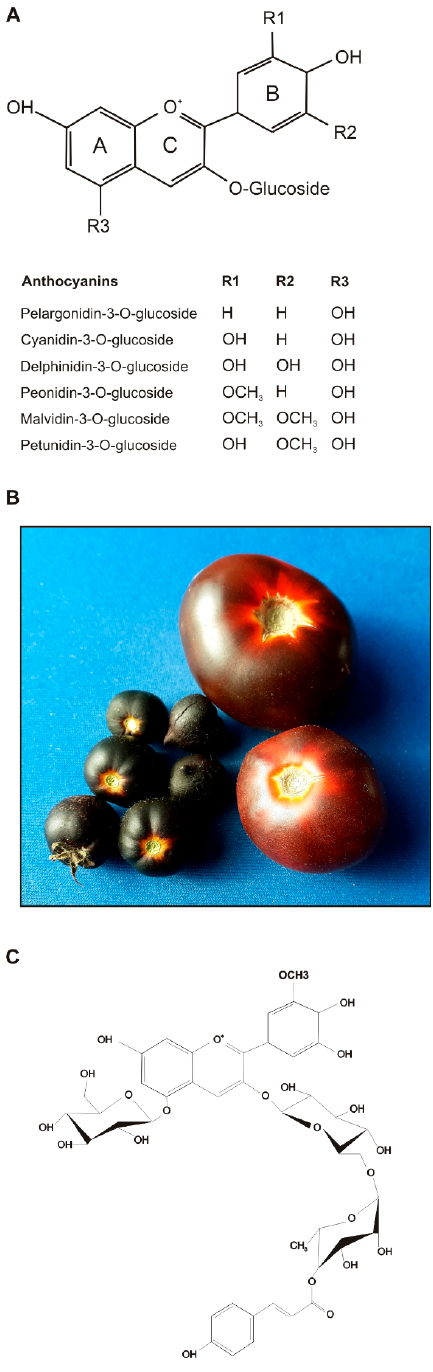
Figure 1. General anthocyanin structure and list of the most common anthocyanins found in nature (from [5]) ( A ). Examples of purple tomato fruits obtained by breeding: Aft / Aft x atv / atv x hp2 / hp2 in MicroTom background (on the left); Aft / Aft x atv / atv in Ailsa Craig background ( B ). Structure of petunidin-3-(trans- p -coumaroyl)-rutinoside-5-glucoside, one of the most abundant anthocyanin molecules identified in purple tomato fruits ( C ). Redrawn from [6].